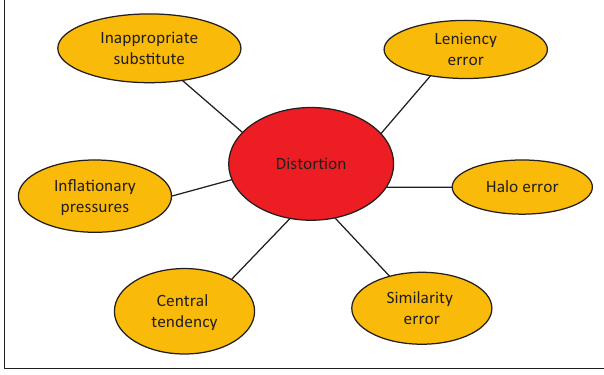
FIGURE 1: Factors that distort